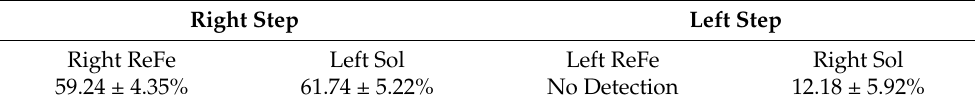
Table 2. The % gait cycle when onset of muscle activation was detected for each muscle. Right